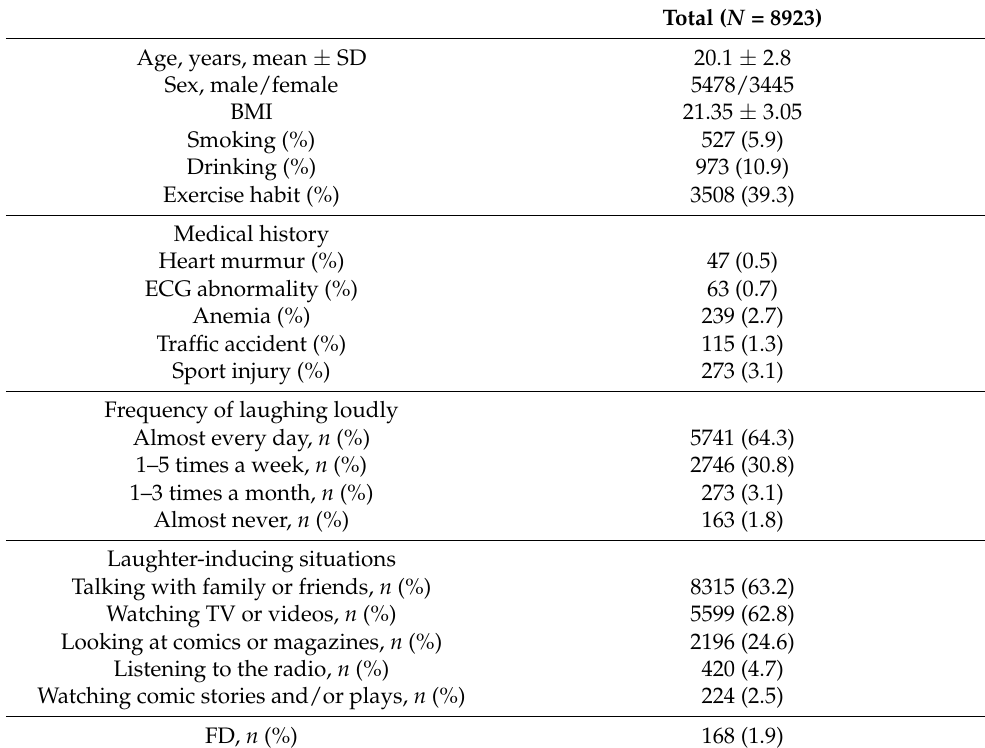
Table 1. Clinical characteristics of 8923 study